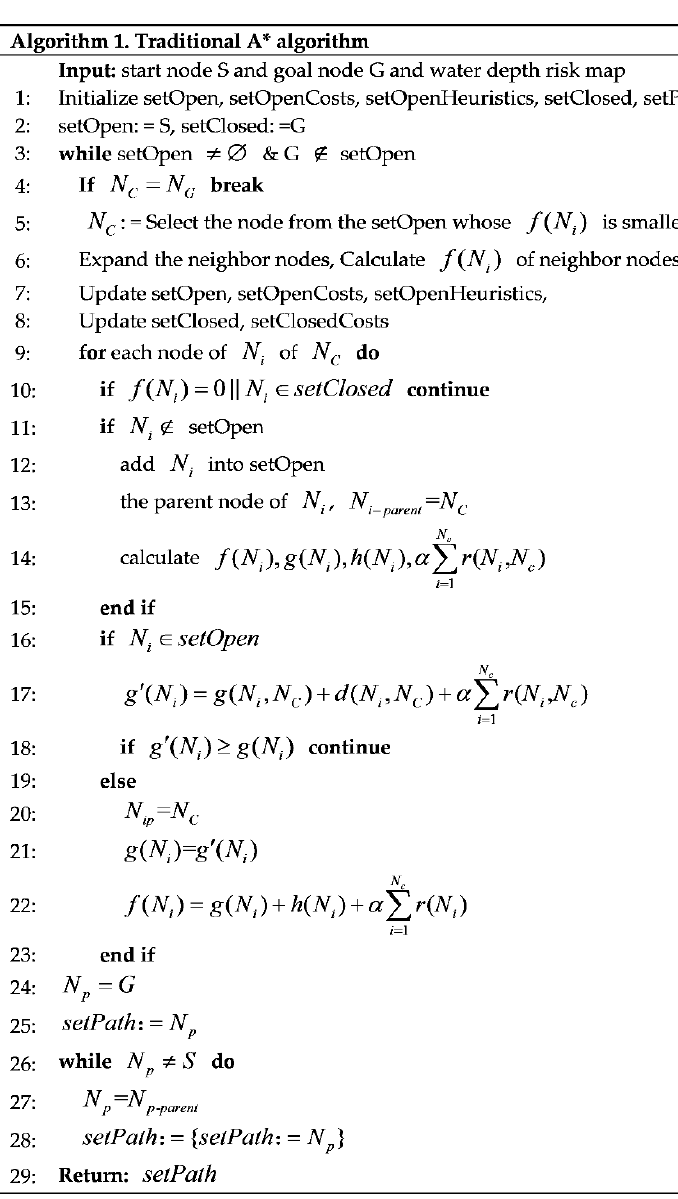
Figure 11. WDRLA* algorithm pseudo code chart.